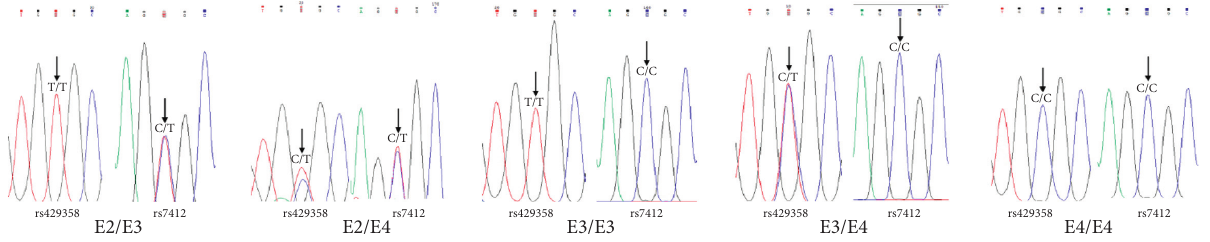
Figure 1: Apolipoprotein E genotyping on clinical DNA samples by sequencing. Table 2: Apolipoprotein E genotype and allele frequencies of